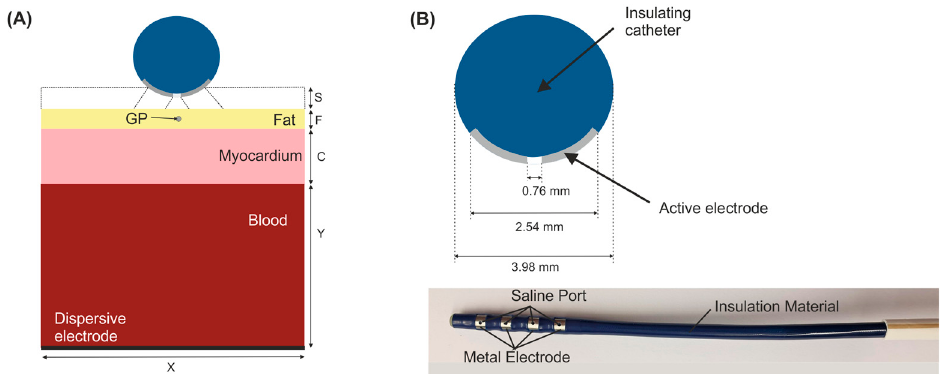
Figure 1. ( A ) Geometry of the 2D limited-domain model which only considers a fragment of the region of interest around the ablation device. Different layers were included below the ablation device: a saline layer (S = 0.5 mm) placed over an epicardial fat surface (F), myocardium (C = 2.7 mm) and blood layers. A ganglionated plexi (GP) with an area of 0.07 mm 2 [4] is included in the centre of the epicardial fat layer below the ablation device. The dispersive pad is placed on the bottom surface of the model. ( B ) Detail of a circular section of the ablation device (AtriAN Medical, Galway, Ireland) with a hole in its centre for saline infusion [2,5].